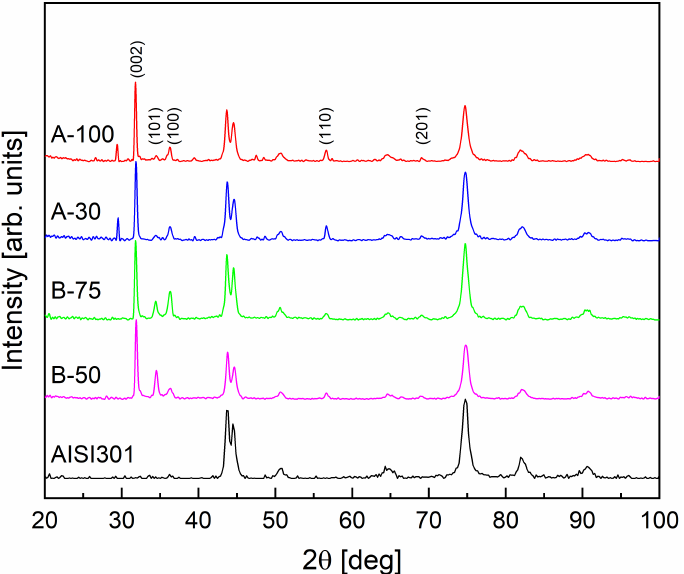
Figure 9. XRD patterns of examined ZnO structures. Data for AISI 301 substrate is shown as a